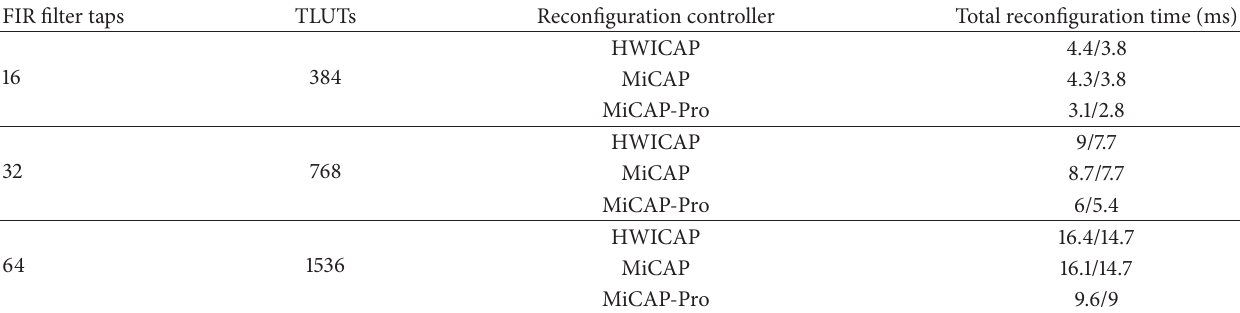
Table 9: Reconfiguration time using type 2 drivers.